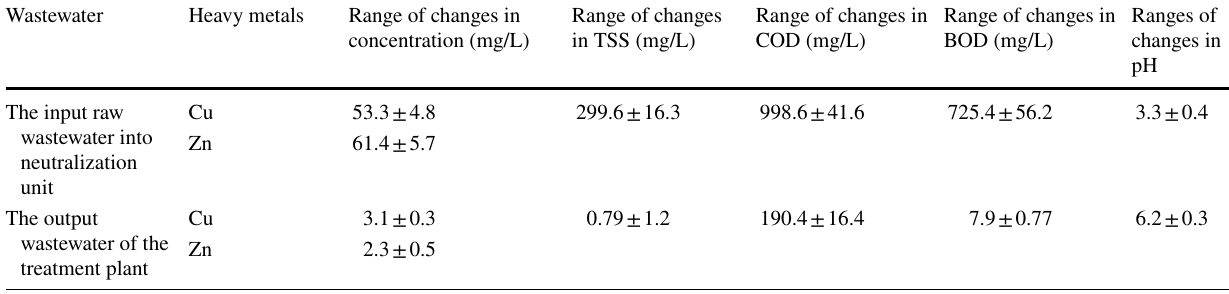
Table 1 The results of qualitative analysis of the input raw wastewater into the neutralization unit and the output wastewater leaving the treat- ment plant of Bahonar copper complex